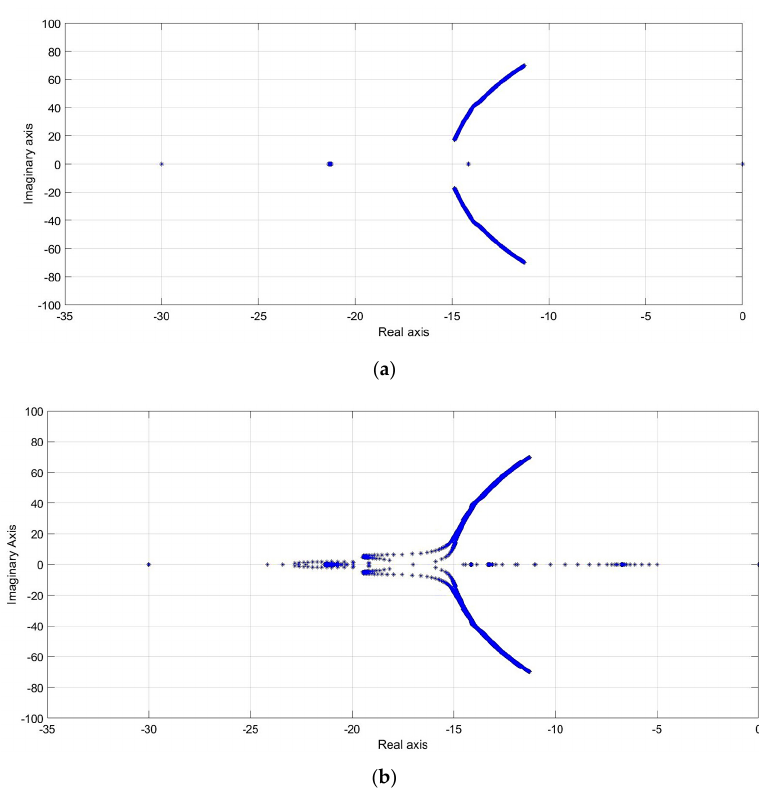
Figure 11. The eigenvalues of system, 5 × 10 − 5 > (cid:1865) (cid:1868) > 5 × 10 − 3 where ( a ) lines inductances neglected, ( b ) when L_Line1 = 10 − 3 H (cid:1853)(cid:1866)(cid:1856) L_Line1 = 2 × 10 − 3 H ( b ) when L_Line1 = 10 − 3 H and L_Line1 = 2 × 10 − 3